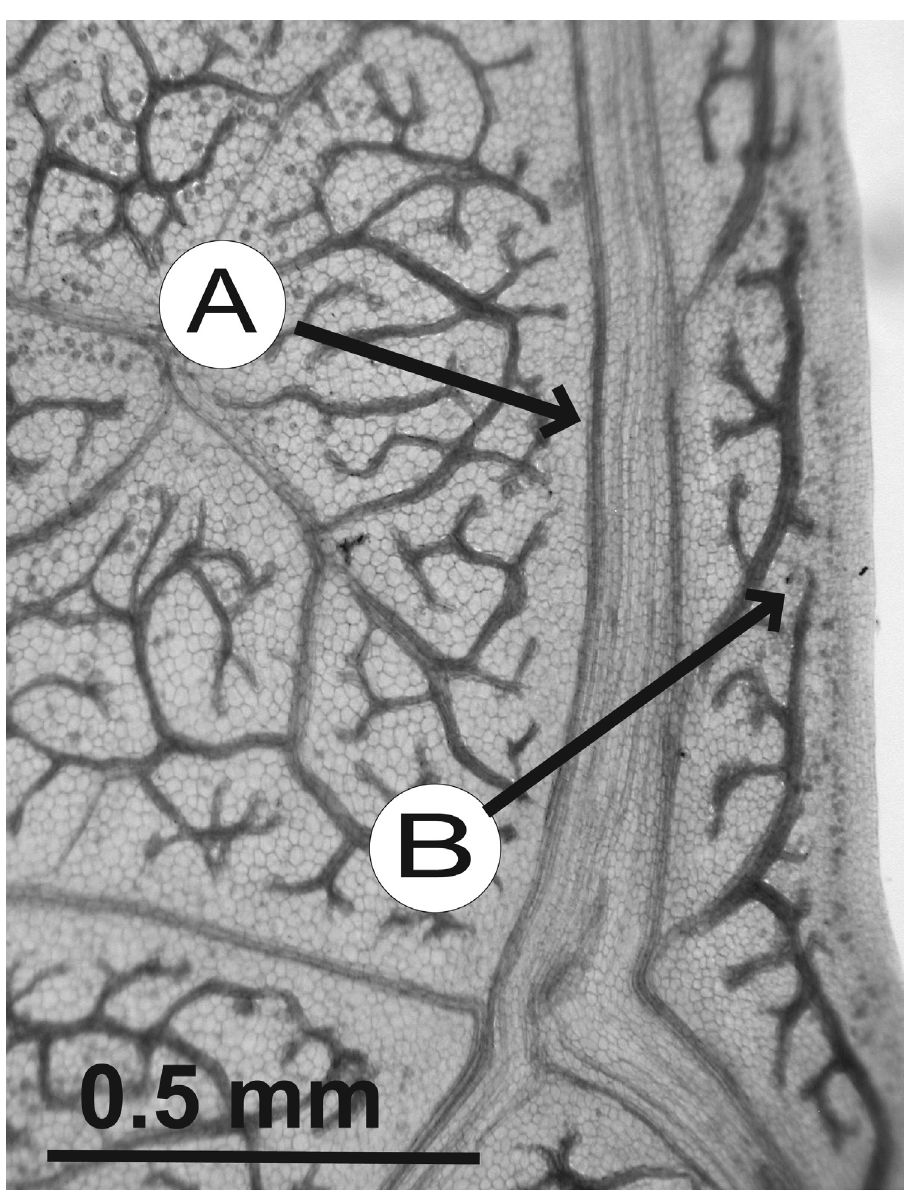
Figure 10. Leaf architecture of Spondias globosa (contd.) . A Intramarginal vein B Incompletely looped marginal ultimate venation. (from Nelson 786 ,